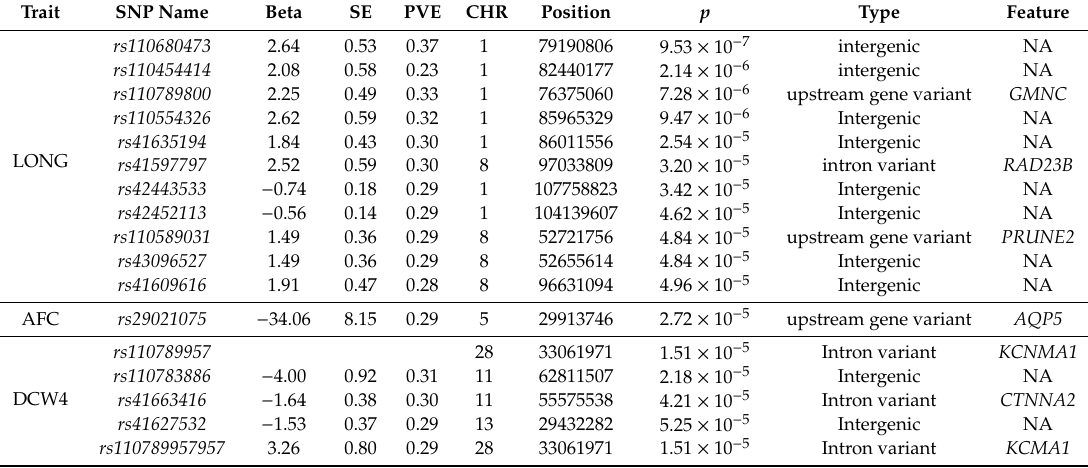
Table 4. List of SNPs significantly associated with longevity (LONG), age at first calving (AFC) and direct genetic e ff ects for calf weight at 4 months (DCW4) identified by GWAS, with corresponding slope (Beta) and standard error (SE), proportion of the variance explained by the SNP (PVE), chromosome location CHR—Position), significance ( p -value), type of location (Type) and associated genes (Feature; NA: not